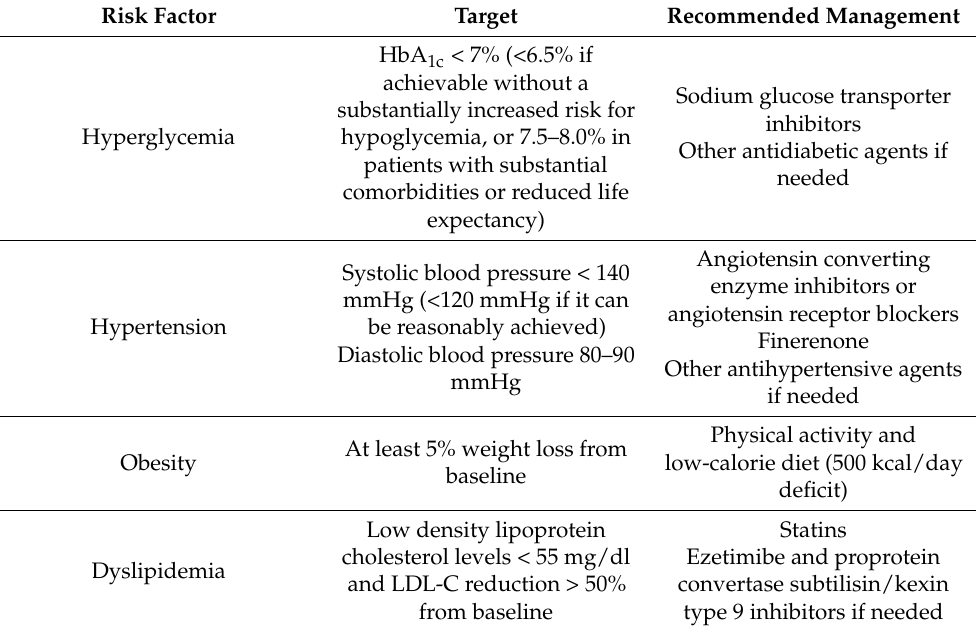
Table 1. Major risk factors for kidney disease in patients with diabetes mellitus and their management.